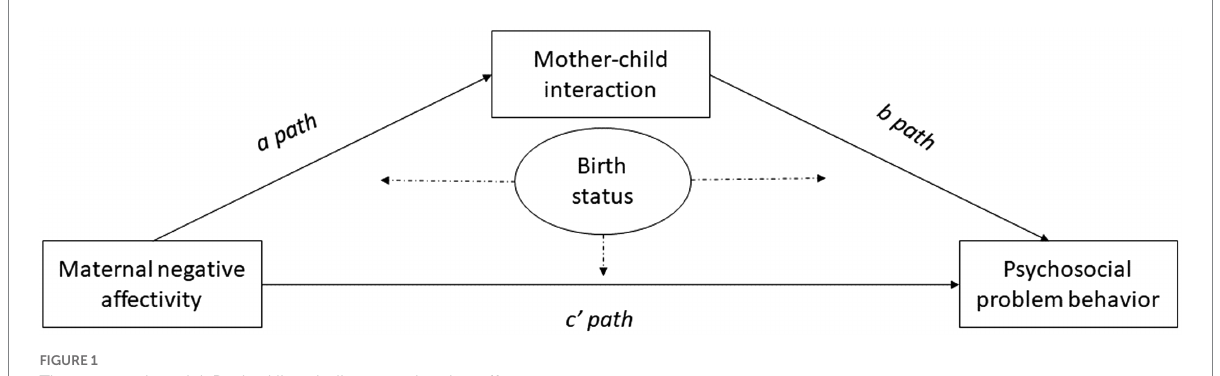
FIGURE 1 The proposed model. Dashed lines indicate moderation